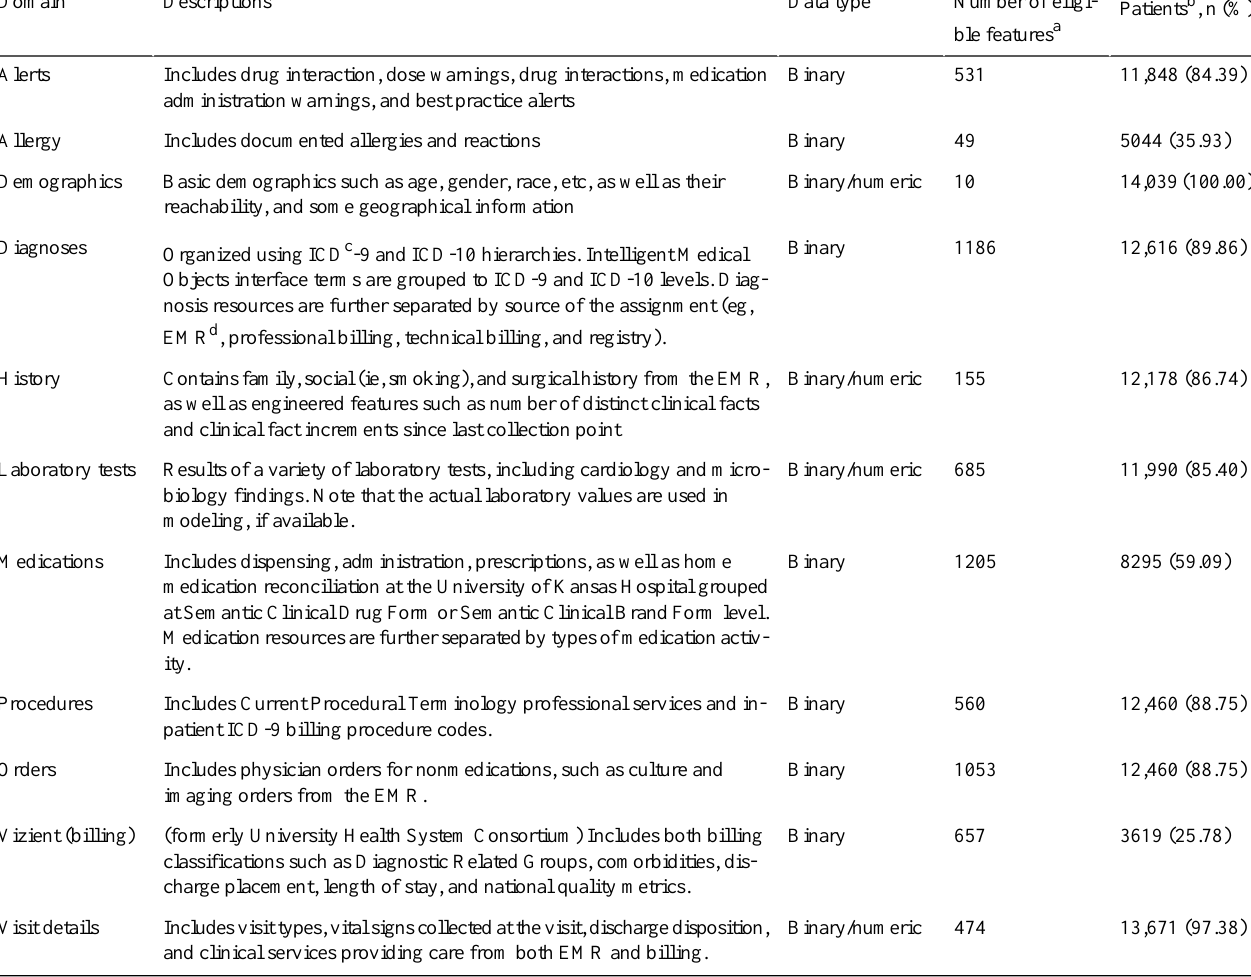
Table 1. Integrated data repository data domain